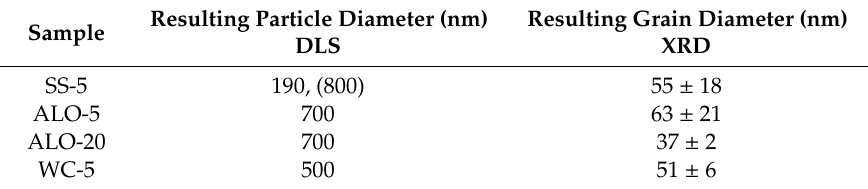
Table 2. Particle and grain sizes of samples ground in di ff erent